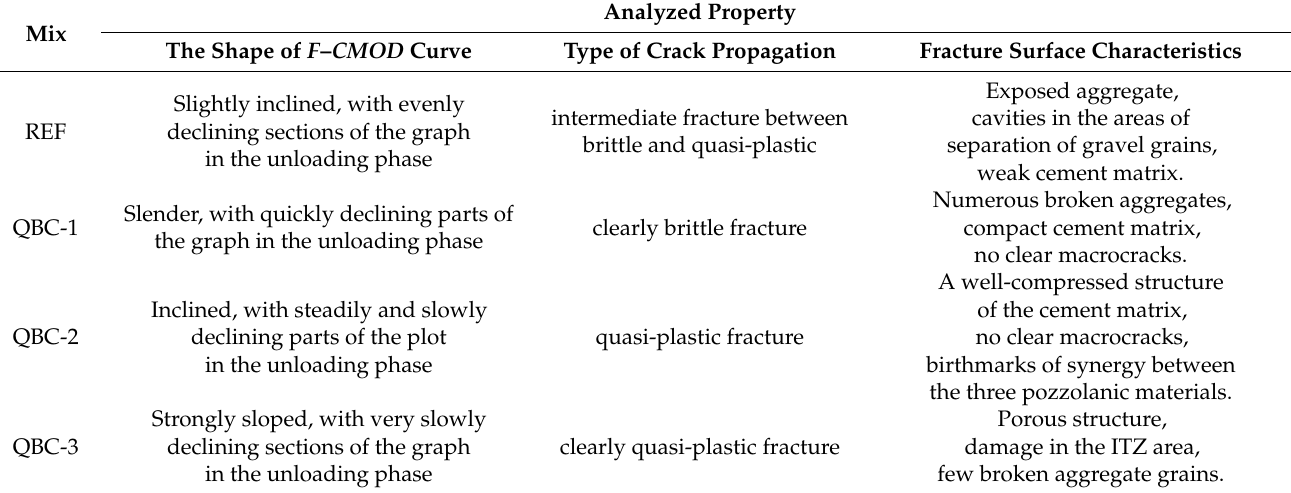
Table 5. Characteristics features of QBCs, resulting from fracture toughness